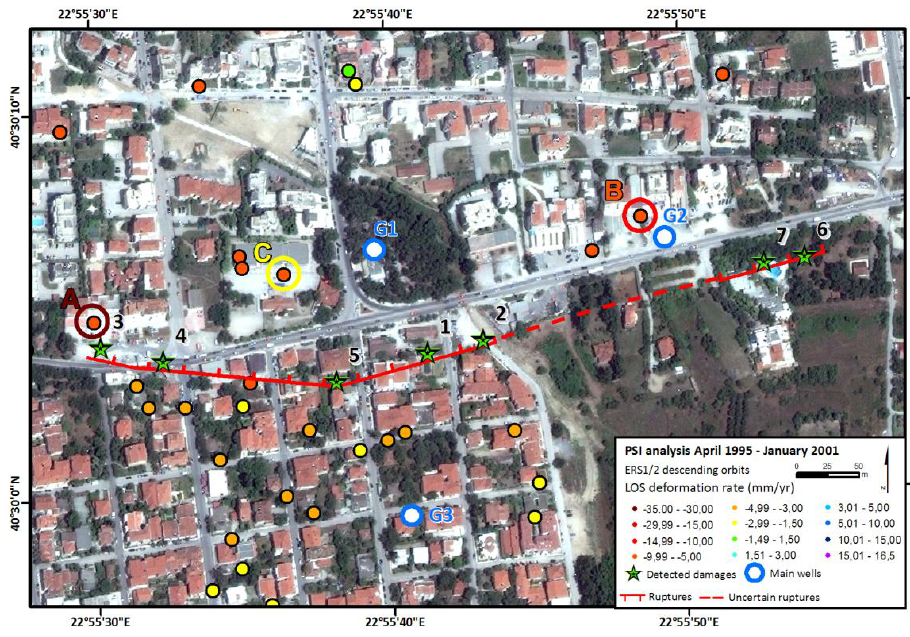
Figure 9. Close-up of PSI data for Perea village. Green stars indicate surveyed points of Fig. 11.